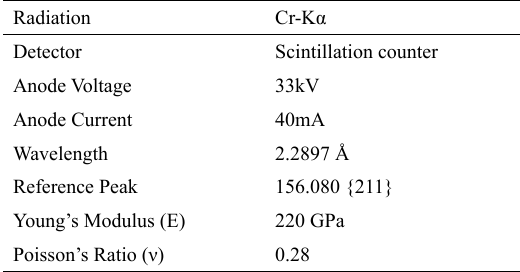
Table 2. Parameters used in the